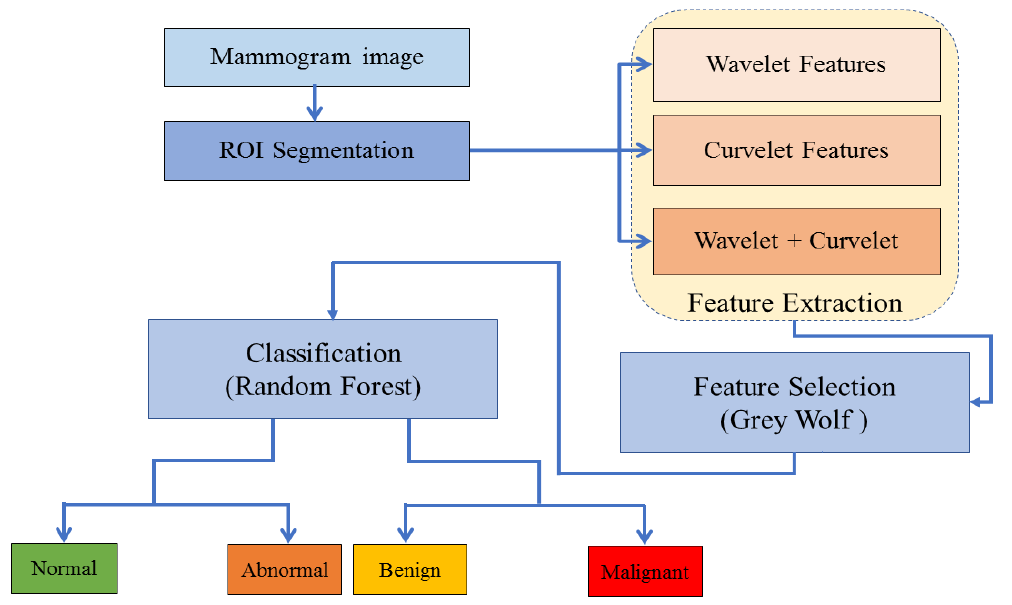
Figure 1. The proposed method for mammographic image